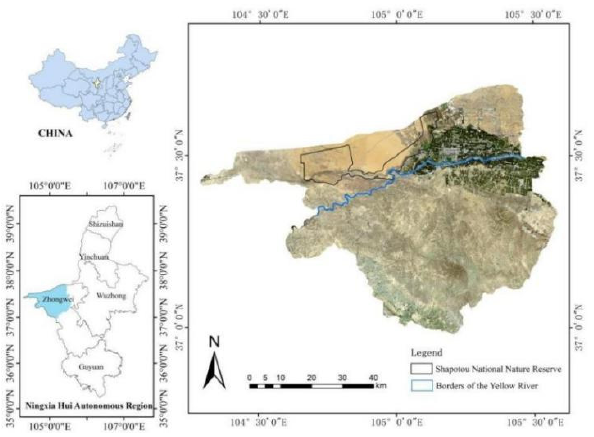
Figure 2. Location of the study area (the right-hand side of the image shows Landsat-7 ETM+ data from March 2019).